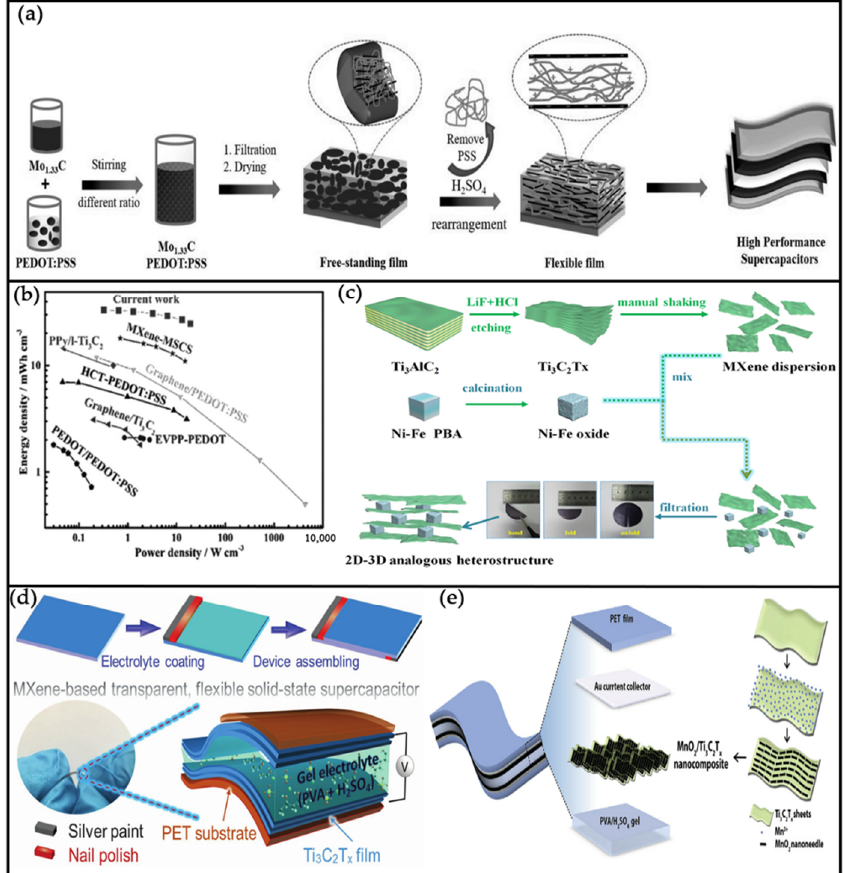
Figure 12. ( a ) Schematic illustration of the preparation of composite films and the fabrication of a solid-state SC. ( b ) Energy and power density of the M:P = 10:1 − 24 h device compared with previously reported devices. Reprinted with permission from Ref. [167]. Copyright 2017 WILEY-VCH Verlag GmbH & Co., KGaA. ( c ) Schematic illustration of the fabrication process for the composite film electrode. Reprinted with permission from Ref. [157]. Copyright 2020 Chemical Engineering Journal . ( d ) Schematic demonstration of Ti 3 C 2 T x MXene-based transparent, flexible solid-state supercapacitor fabrication. Reprinted with permission from Ref. [168]. Copyright 2017 WILEY-VCH Verlag GmbH & Co., KGaA. ( e ) Schematic illustration of the MnO 2 /Ti 3 C 2 T x nanocomposite-based flexible supercapacitor preparation. Reprinted with permission from Ref. [169]. Copyright 2018 Electrochimica Acta .